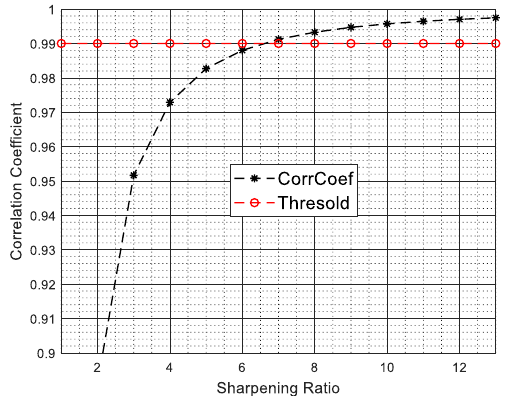
(cid:0) (cid:1) f and a ( f si + ∆ /2 ) versus the sharpening si